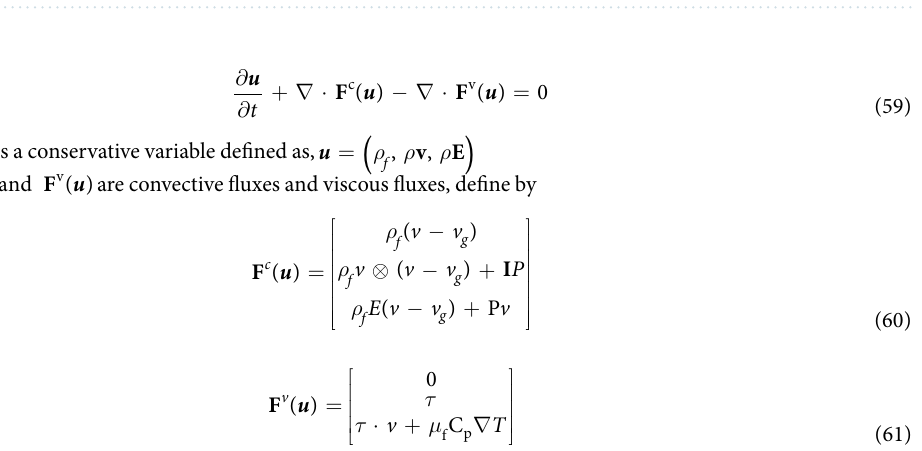
Figure 2. Surface mesh for the CFD